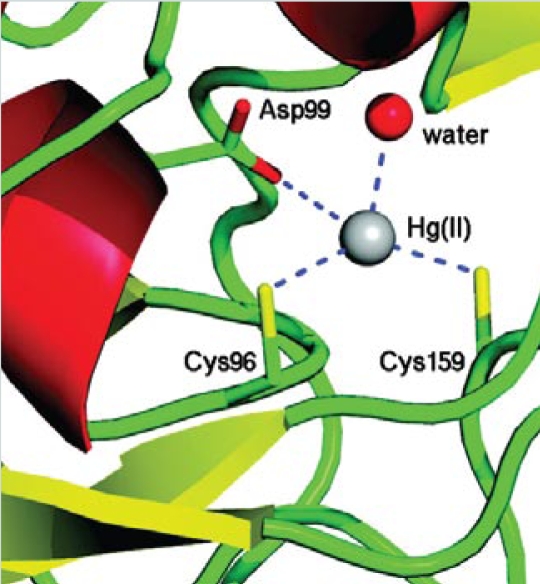
Active site of MerB